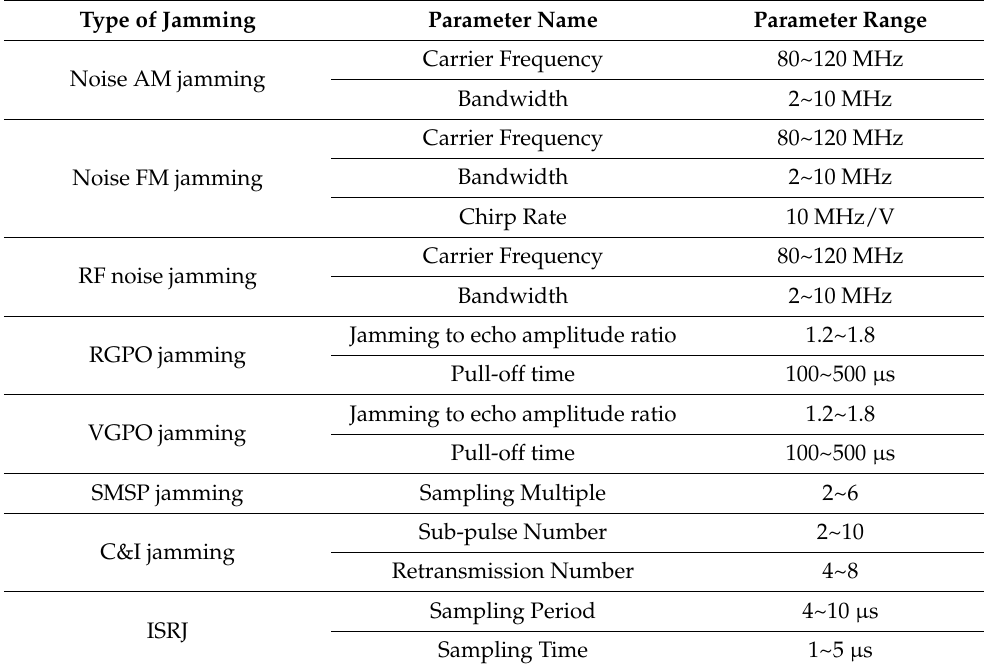
Table 1. Radar active jamming dataset parameters settings.